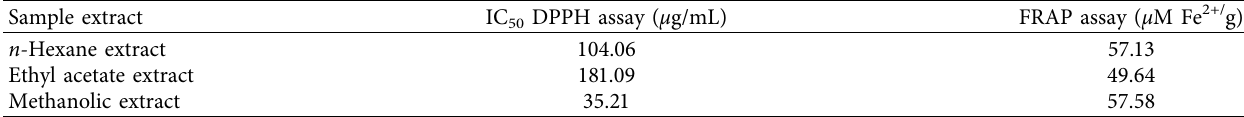
Table 1: Result of antioxidant activity from DPPH and FRAP assays of various okra pods extracts. Sample